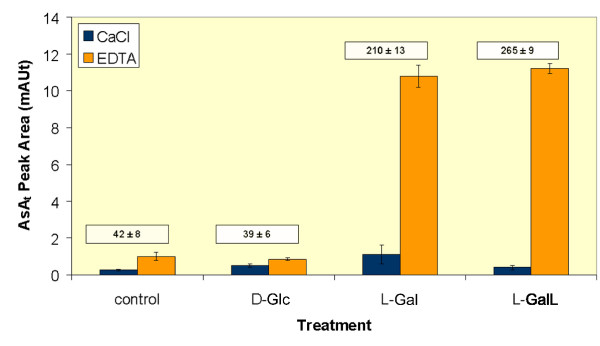
AsAt content of petiole exudates after treatment of source leaves with AsA precursors. Terminal leaflets of glasshouse grown potato plants were supplied with 500 μl of the substrate indicated (25 mM) via a 'flap' whilst still attached to the plant. After 24 h incubation, leaflets were removed for AsAt determination in tissues and collection of exudates (90 min). Bars represent the mean exudate AsAt peak area ± SE (n = 4) and values in boxes represent the mean tissue AsAt content (mg/100 gFW) ± SE (n = 4). mAUt = milli-absorbance units (λ245 nm) × time